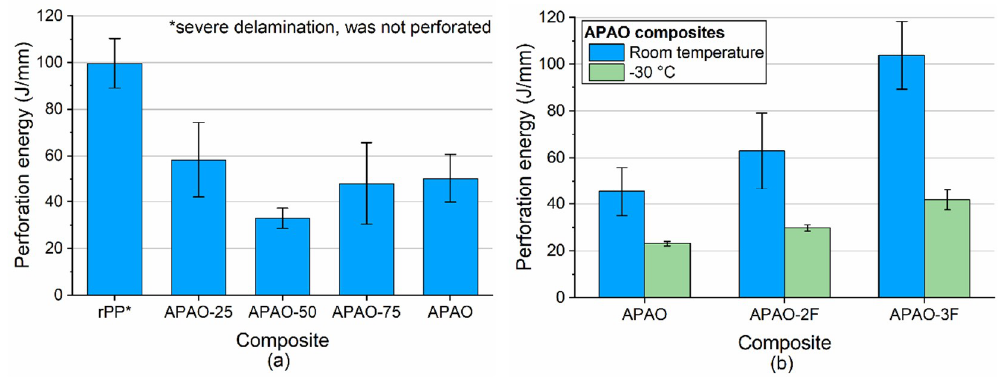
Figure 13. ( a ) perforation energy of the composites and ( b ) perforation energy of the composites with different reinforcement content